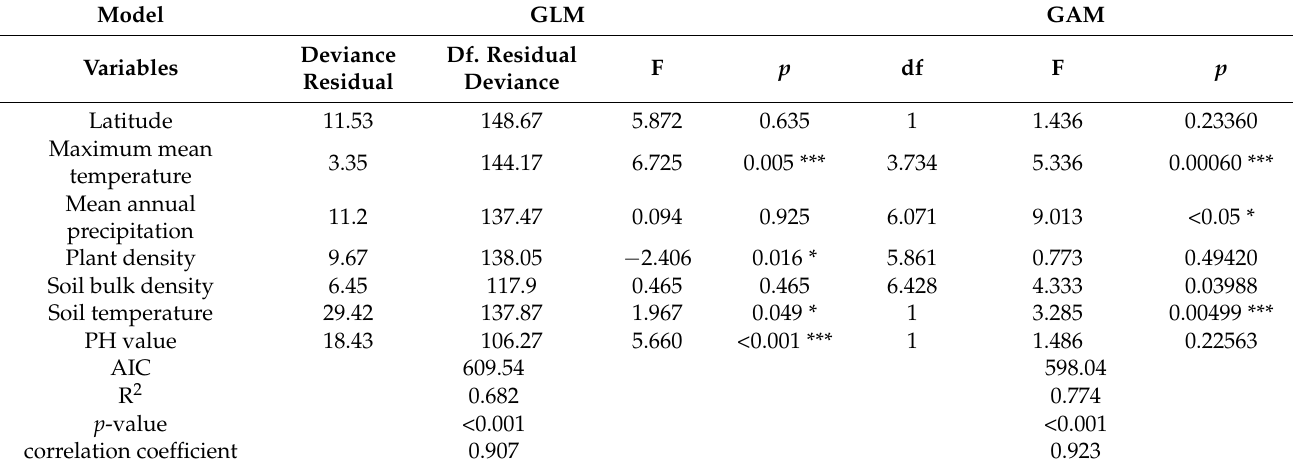
Table 1. Summary of stepwise of the GAM and GLM of